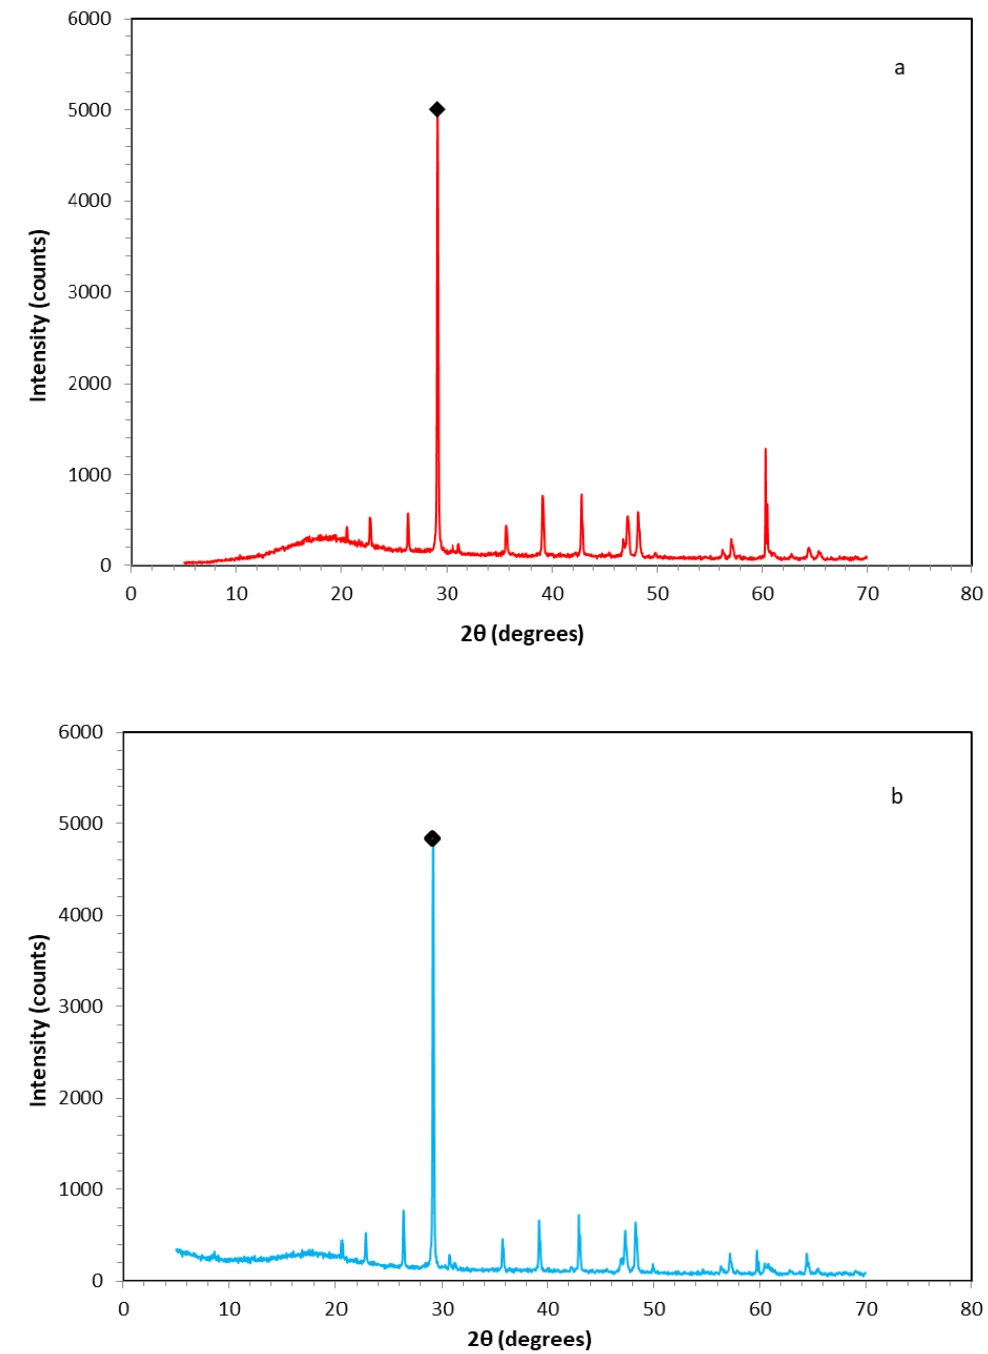
Figure 7. X-ray diffractograms of produced filling powders; ( a ) C&D waste (CDW) powder of 300 µ m and ( b ) CDW powder of 500 µ m. (The black square mark indicates the 2 θ = 29.1 ◦ , which is assigned to the calcite crystalline phase).